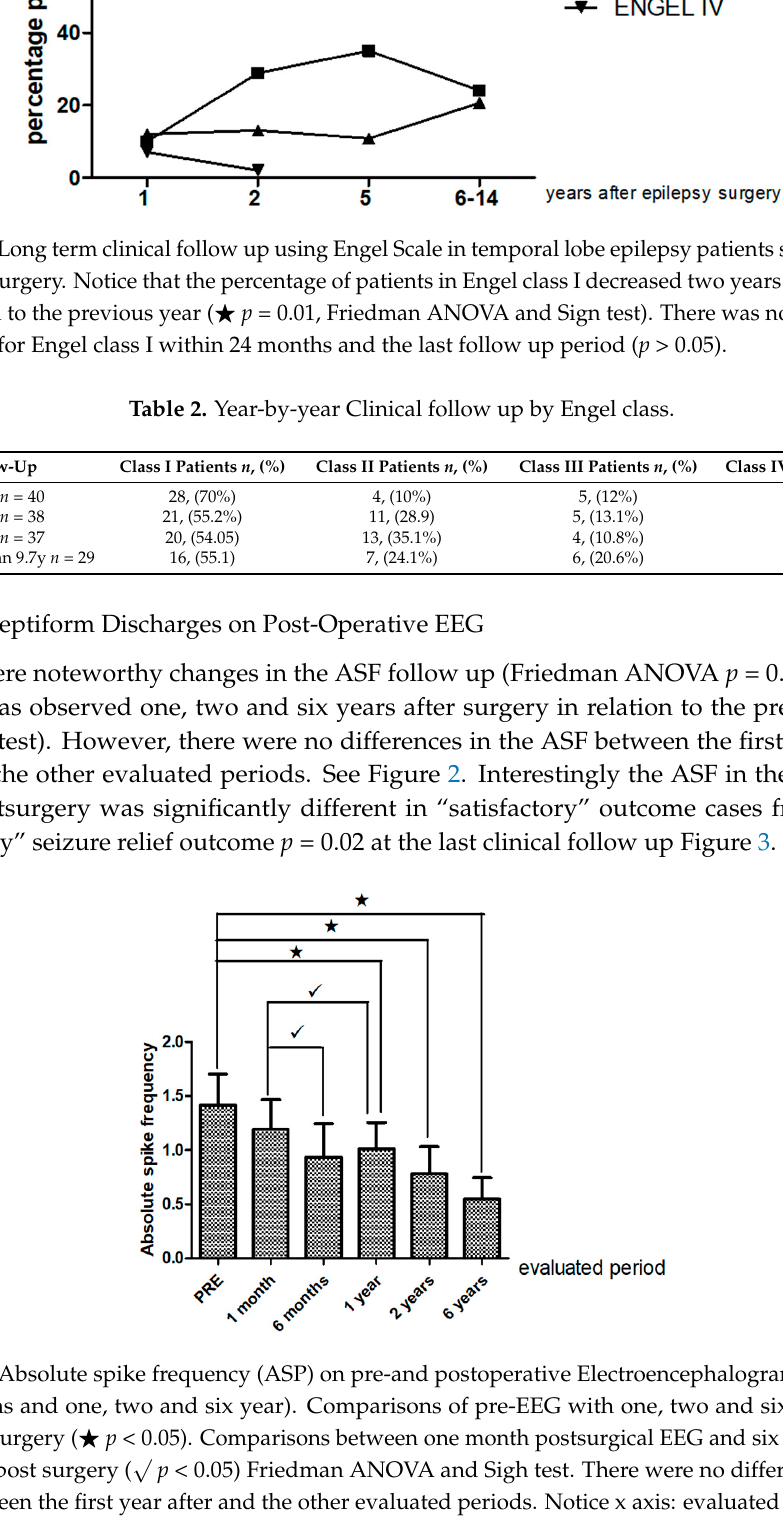
Figure 1. Long term clinical follow up using Engel Scale in temporal lobe epilepsy patients submitted to epilepsy surgery. Notice that the percentage of patients in Engel class I decreased two